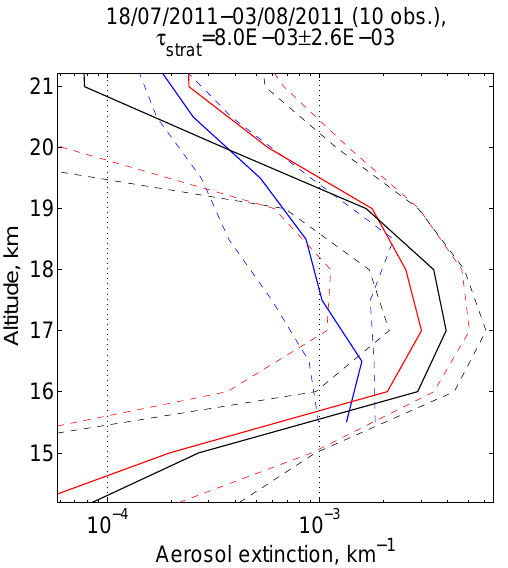
Fig. 12. The dashed lines and the solid line are 15.87th, 84.13th and 50th percentiles correspondingly for the ensembles of retrieved aerosol extinction profiles (black), OSIRIS aerosol extinction pro- files (blue) and aerosol extinction profiles retrieved from twilight measurements, using a new multiple scattering correction factor (red). The stratospheric optical depth indicated above the figure was estimated using the corrected aerosol profiles.